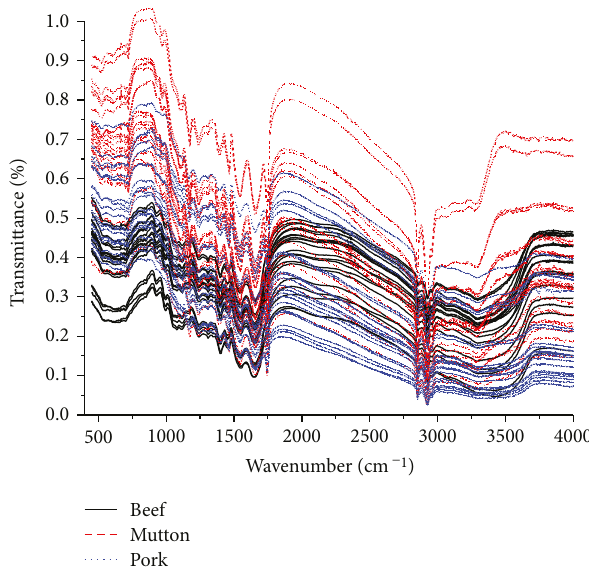
Figure 1: Unique absorbed spectra of pork (blue), beef (black), and mutton (red) using infrared spectroscopy.